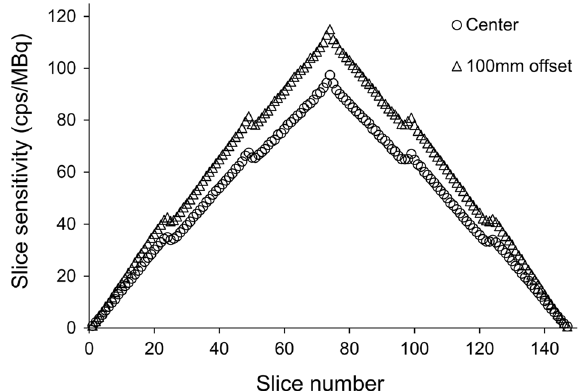
Fig. 2 Axial sensitivity profile at the center of the FOV and at 100 mm off‑center